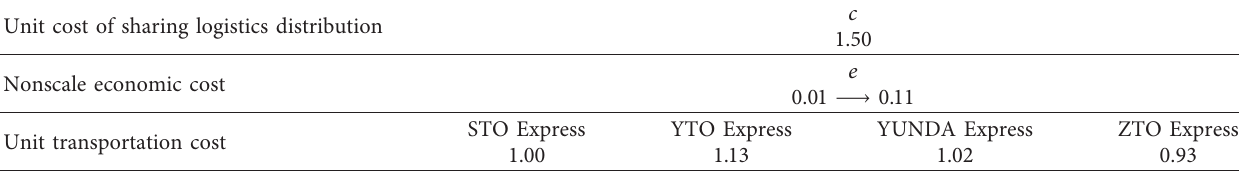
Table 3: Operating cost data of listed express delivery